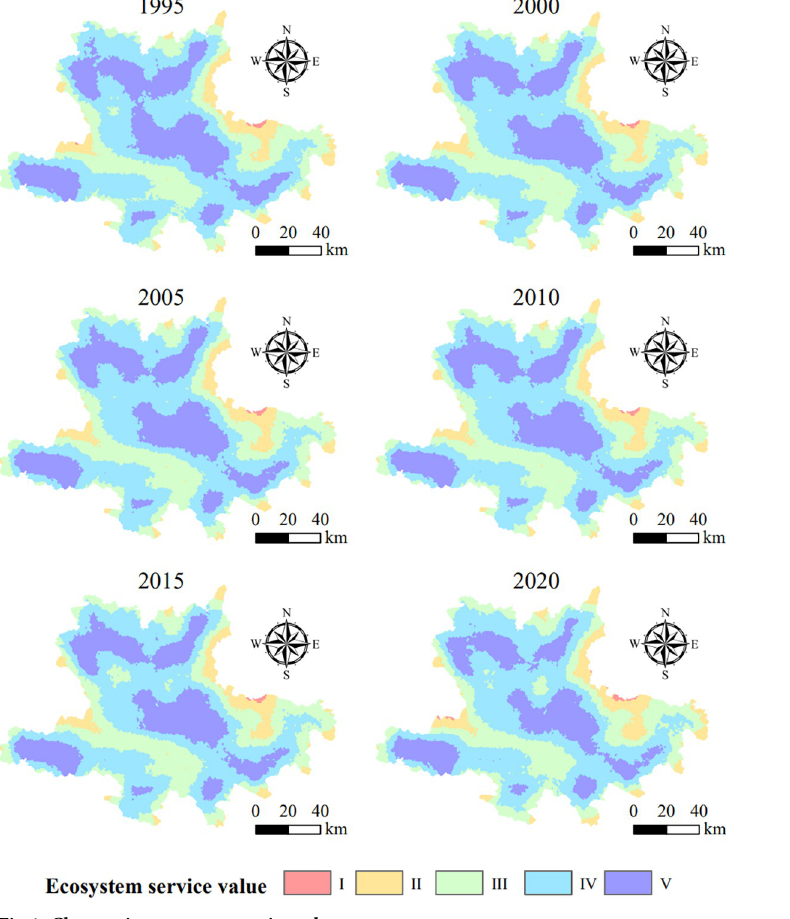
Fig 4. Changes in ecosystem service